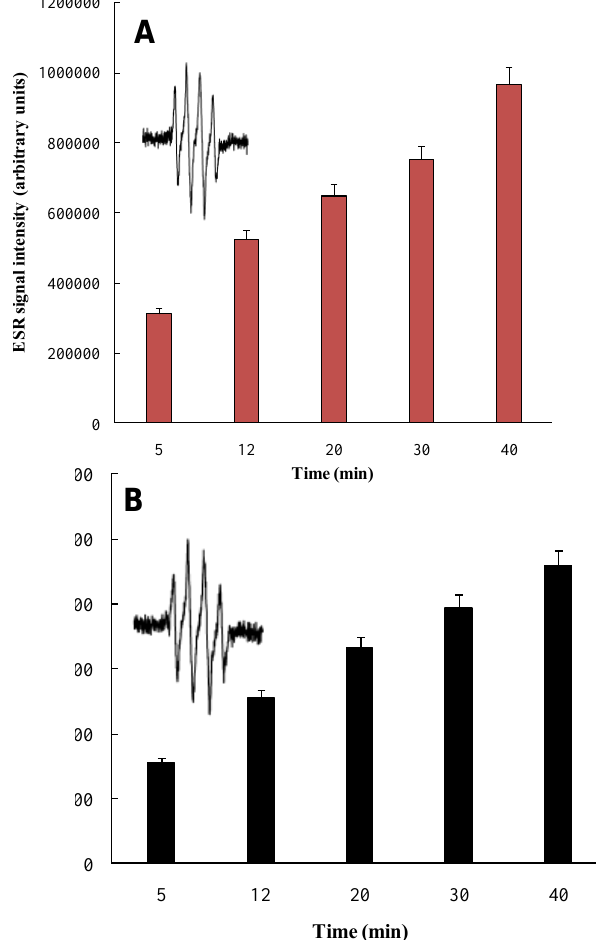
Figure 7. The generation of superoxide from ( A ) 4-nitropyrene and ( B ) 4-nitro-BeP. Samples contained 0.9 mM 4-nitropyrene or 4-nitro-BeP and 25 mM 5- tert -butoxycarbonyl-5- methyl-1-pyrroline- N -oxide (BMPO) in 90% CH CN. Samples were irradiated at 420 nm, and 3 ESR signal recorded after different time intervals. ESR instrument settings were as follows: 20 mW microwave power, 100 G sweep width, 1 G field modulation amplitude, and 100 kHz modulation frequency. The insert is the continuous wave ESR spectrum of